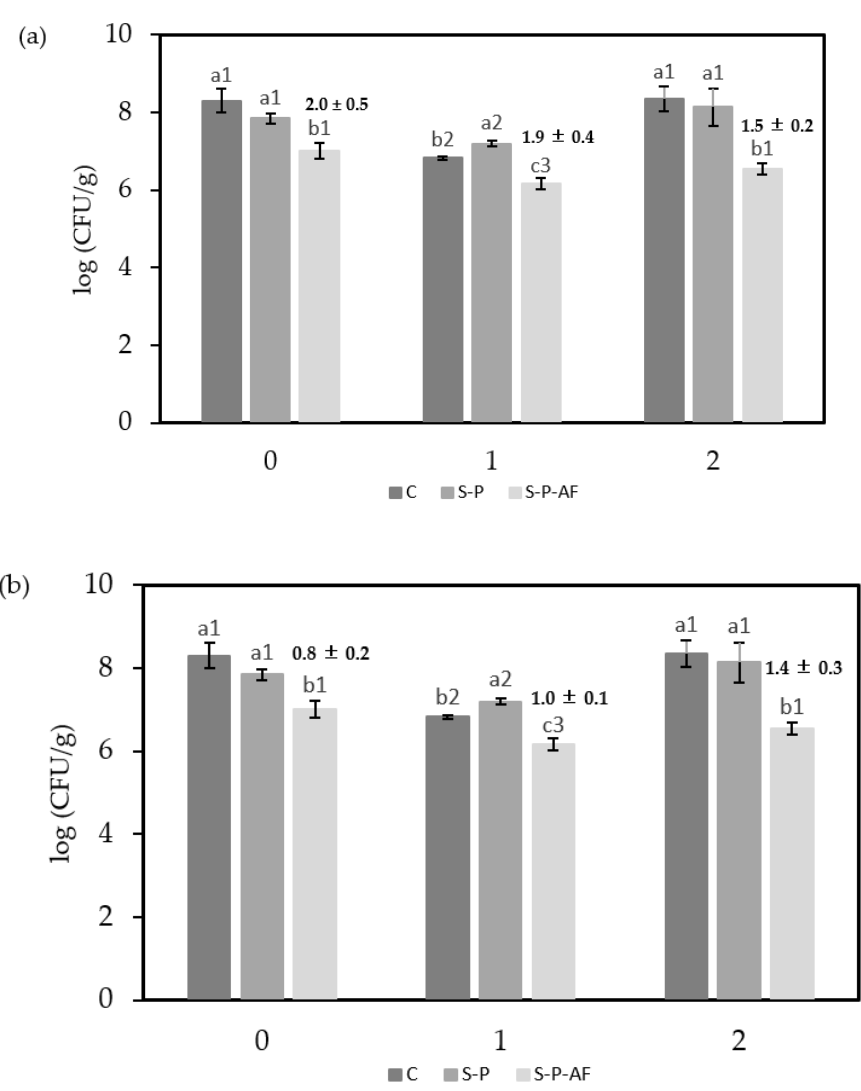
Figure 4. Microbial counts for ( a ) Listeria innocua and ( b ) Escherichia coli obtained after 6 days of incubation at 10 °C in TSA medium. Uncovered control plates (C), and covered plates with starch- polyester bilayer films: films without FA (S-P) and with FA (S-P-AF). Different superscript letters (a–c) indicate significant differences among formulations ( p < 0.05). Different superscript numbers (1–3) indicate significant differences between the three storage times ( p < 0.05). The numeric label on the S-P-AF bars gives the difference between the Log CFU of S-P-AF active film with respect to the S-P film.